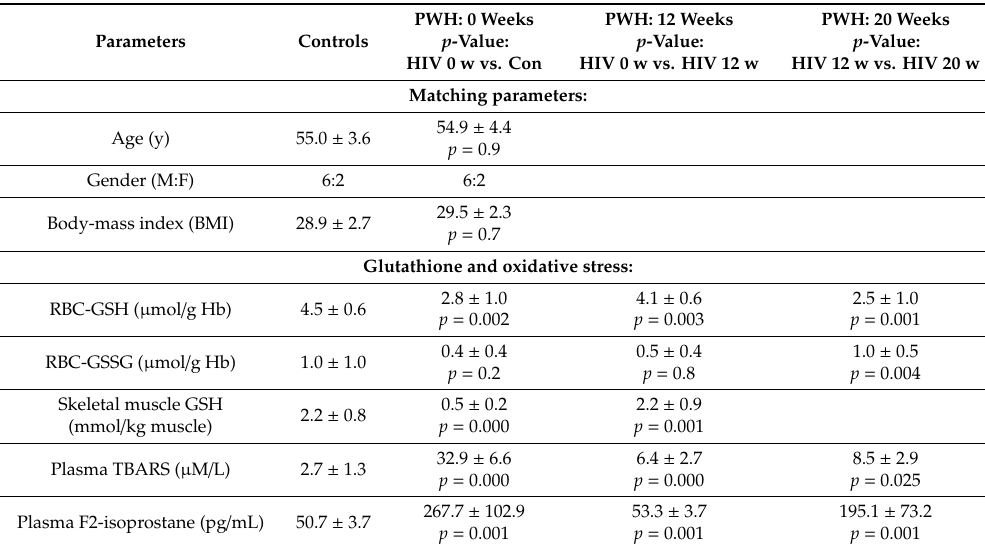
Table 2. E ff ect of GlyNAC supplementation and withdrawal on red blood cells glutathione (RBC GSH) concentrations and oxidative stress in PWH. ‘Controls’ = unsupplemented, uninfected participants; ‘PWH: 0 weeks’ = HIV participants studied before GlyNAC supplementation; ‘PWH: 12 weeks’ = HIV participants 12 weeks after GlyNAC supplementation; ‘PWH: 20 weeks’ = HIV participants 8 weeks after stopping GlyNAC. Values are means ± SD; Means are significantly di ff erent at p < 0.05. BMI = body mass index; Hb = hemoglobin; GSSG = oxidized glutathione; TBARS = thiobarbituric acid reducing substances (a plasma marker of oxidative